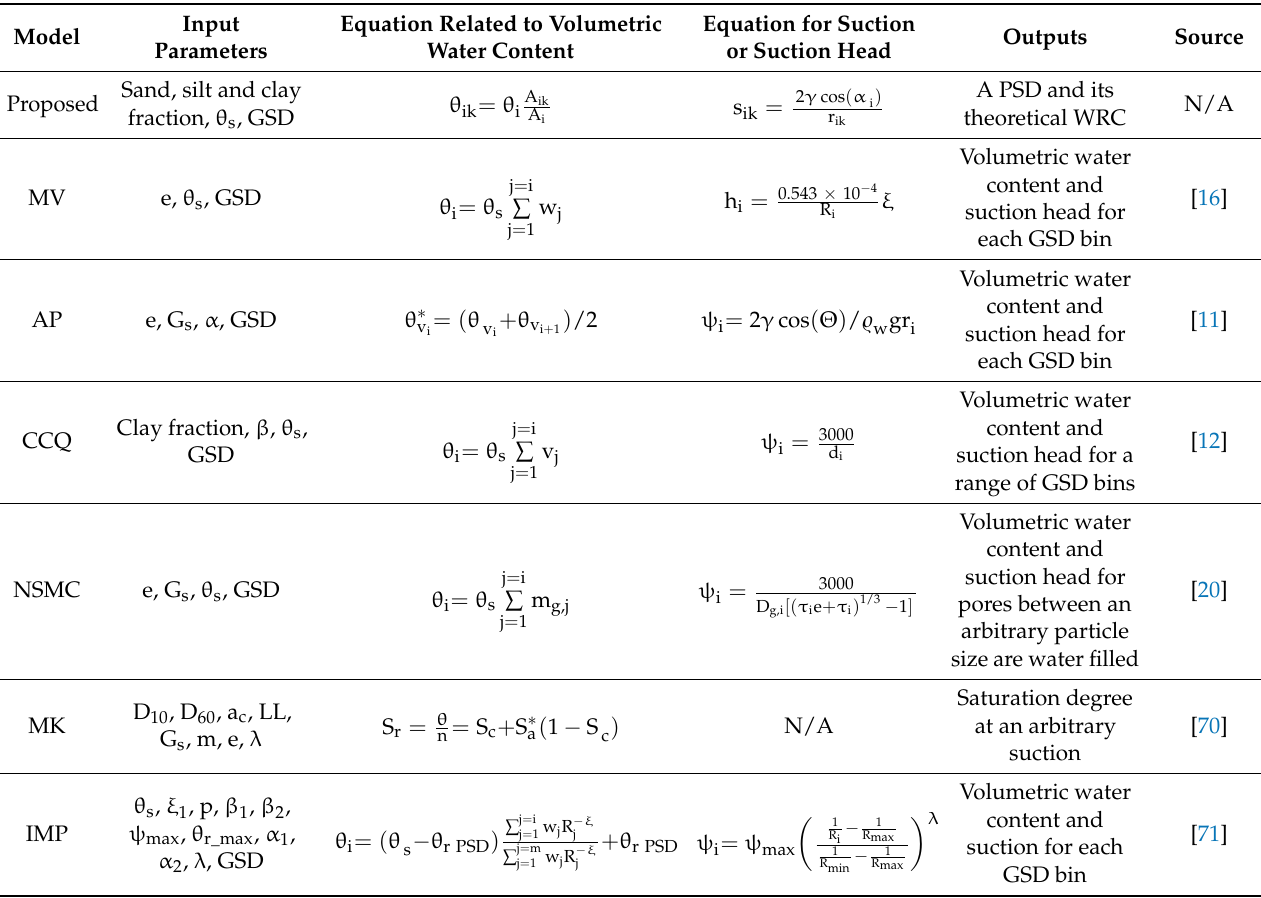
Table 2. Characterization of the proposed WRC model and models used from the literature, showing model inputs and outputs, equations related to estimating suction and volumetric water content, and the source of model. The equations shown are presented as seen from the source and the reader is directed to the relevant source for derivation and explanations of the equations shown. See footnote for definitions of input